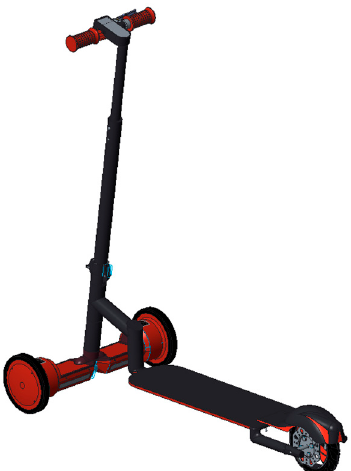
Figure 15. Final assembly.